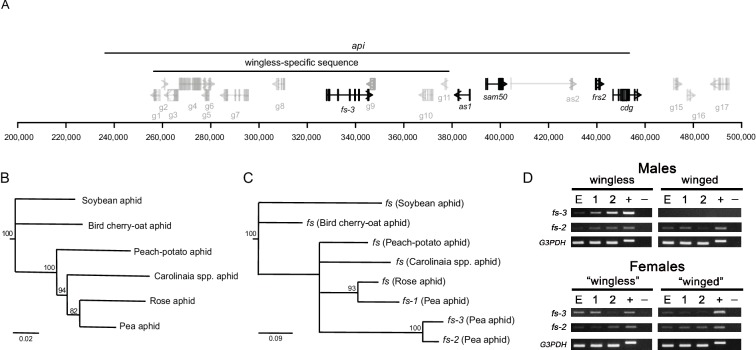
An expressed follistatin gene duplicate in the wingless-specific insertion.(A) Gene models at the api locus, with distances shown in bp on the x-axis. The recombination mapping defined api region and the wingless-allele specific insertion are indicated. ORFs inside the wingless-specific insertion are our own annotation, while those outside the insertion are those of the genome v3.0 (Li et al., 2019). Repetitive ORFs and those outside of the api region are shown in gray. ORFs with evidence for expression either from RT-PCR or RT-qPCR are shown in black. (B) Phylogenetic tree of the aphids studied here: the soybean aphid (Aphis glycines), the bird cherry-oat aphid (Rhopalosiphum padi), the peach-potato aphid (Myzus persicae), an unidentified Carolinaia genus species, the rose aphid (Macrosiphum rosae), and the pea aphid (Acyrthosiphon pisum). The maximum likelihood tree was constructed from 2,378 bp of DNA sequence from elongation factor 1α, 18S rRNA, 12S rRNA, cytochrome b, and cytochrome c oxidase subunit I collected from Genbank. (C) Maximum likelihood tree of the different copies of follistatin (fs) nucleotide sequences. Nodes with bootstrap values < 80 are collapsed. (D) RT-PCR analysis of fs-3 and fs-2 gene expression across different developmental stages (E: embryo cDNA, 1: 1st instar nymph cDNA, 2: 2nd instar nymph cDNA; +: genomic DNA, -: no cDNA) of wingless males, winged males, daughters of crowded adult wingless females (‘winged’ females, which are predominantly winged females), daughters of uncrowded adult wingless females (‘wingless’ females, which are predominantly wingless female samples). Females here are heterozygous for the api locus, and thus have fs-3 as indicated by the positive band in the female gDNA lanes. Data for the G3PDH gene are provided as a positive control.